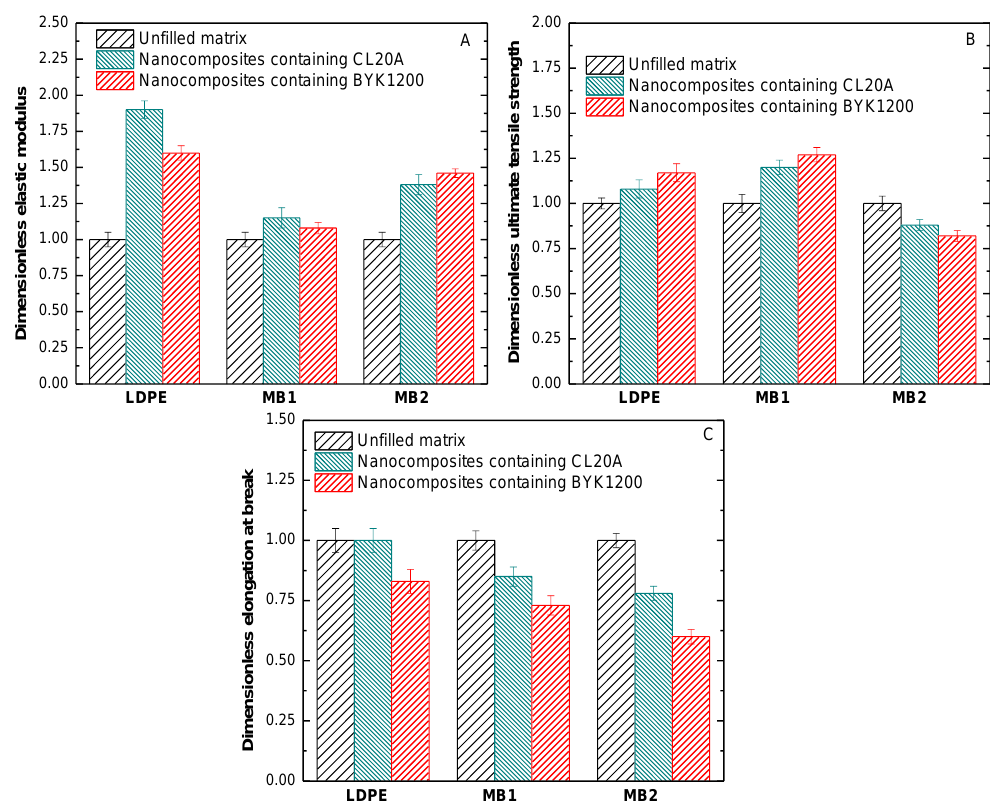
Figure 5. Dimensionless ( A ) elastic modulus, ( B ) ultimate tensile strength, and ( C ) elongation at break for all investigated materials.